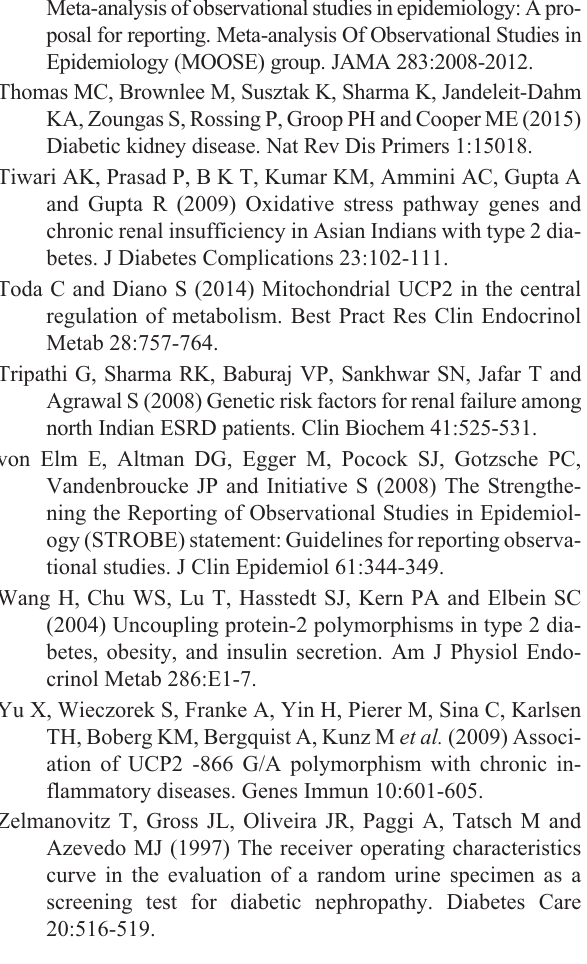
Table S1 - Genotype and allele frequencies of UCP2 -866G/A and Ins/Del polymorphisms. in T1DM patients. Table S2 - Genotype and allele frequencies of UCP2 -866G/A and Ins/Del polymorphisms in T1DM patients and in nondiabetic subjects. Table S3 - Genotype and allele distributions of the UCP2 -866G/A and Ins/Del polymorphisms in T1DM patients with (cases) and without (controls)